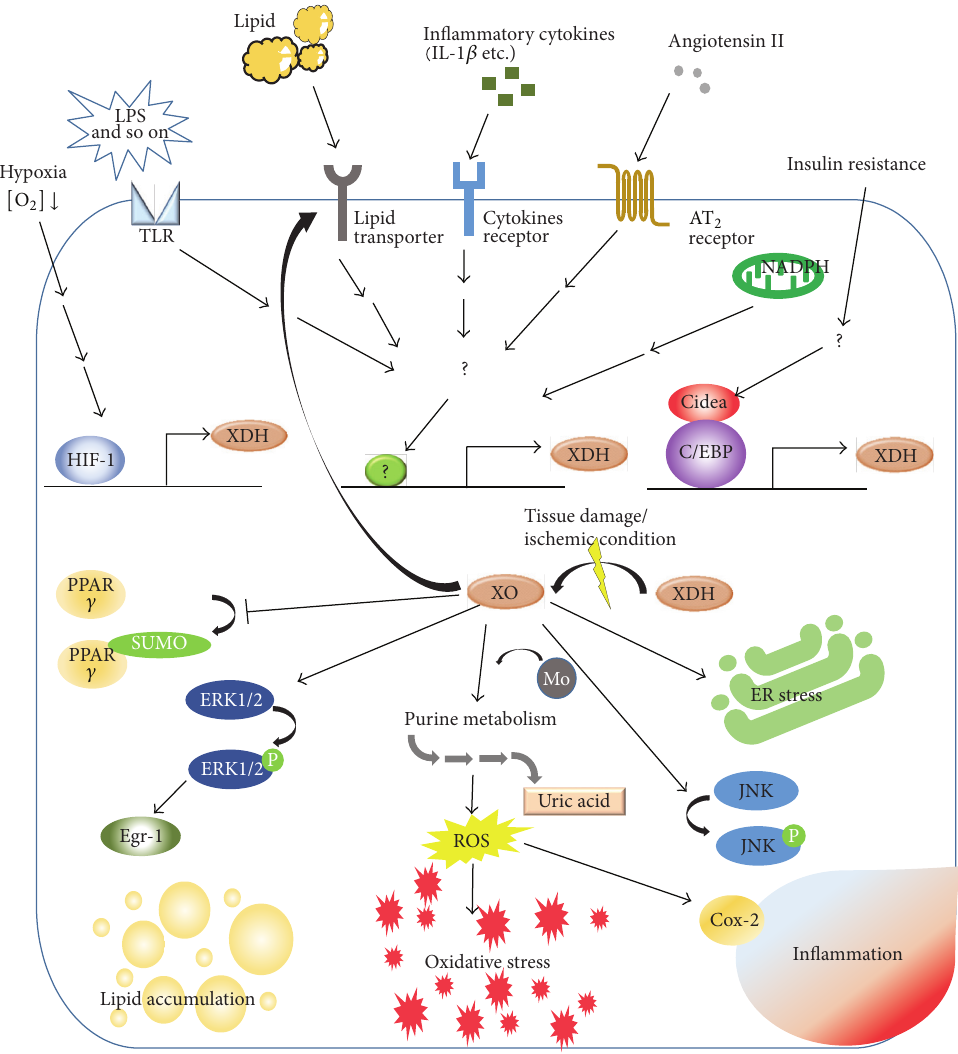
Figure 3: Involvement of XO in molecular pathologies related to inflammation; “causes and